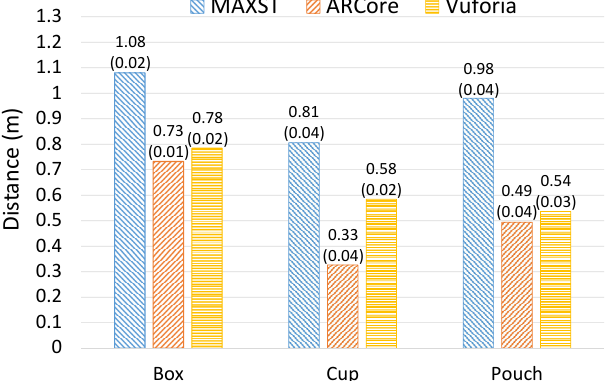
Figure 5. Maximum recognizable distance. (numbers inside parentheses are standard